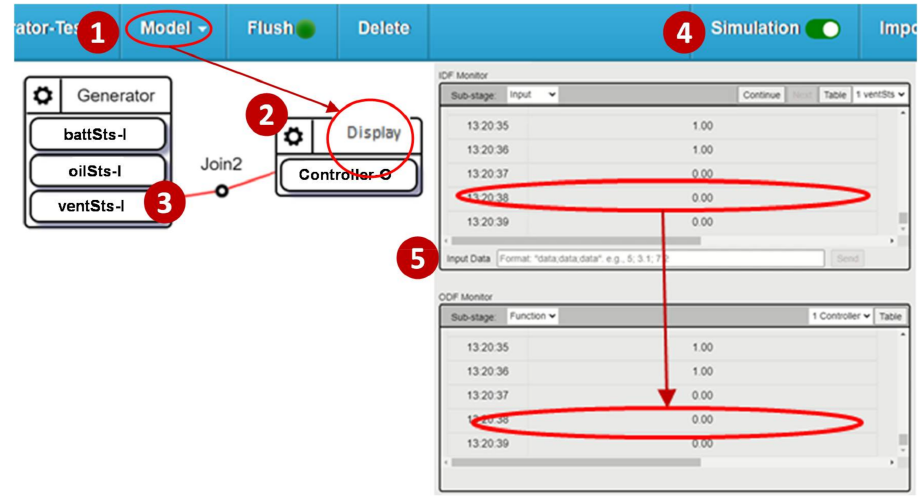
Figure 10. A simple SpecTalk test